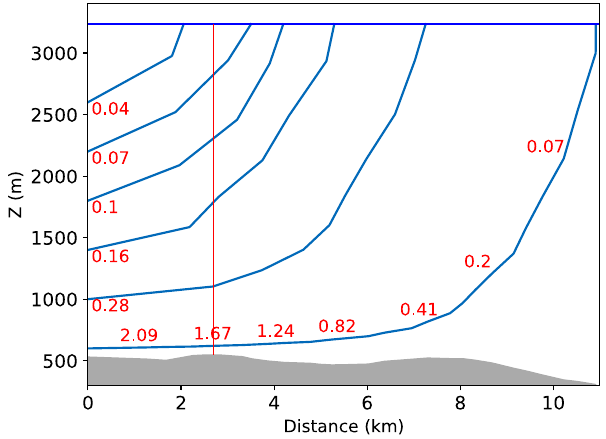
Figure 3. Trajectories of the ice particles from the ice surface to- wards the black point in Fig. 2 (dashed red trajectory). Red numbers indicate the age of the ice, in millions of years. The bed profile is shown in grey. The thin red line corresponds to one possible drill site (red point in Fig.